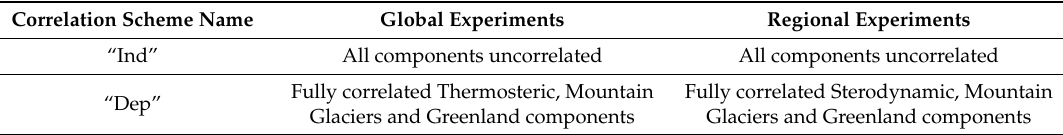
Table 3. Dependencies schemes used in this